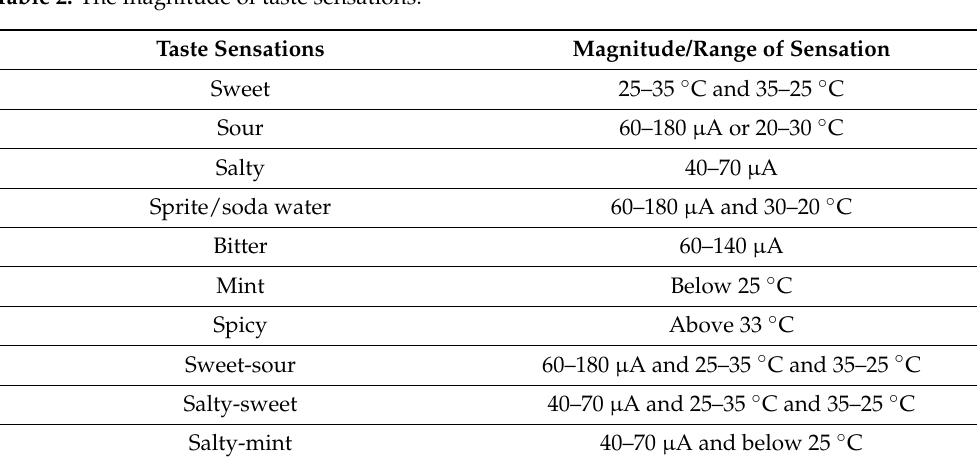
Table 2. The magnitude of taste